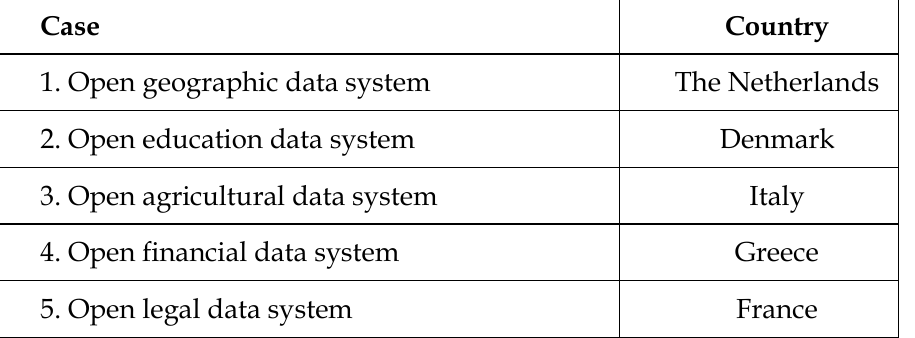
Table 1: Case study overview